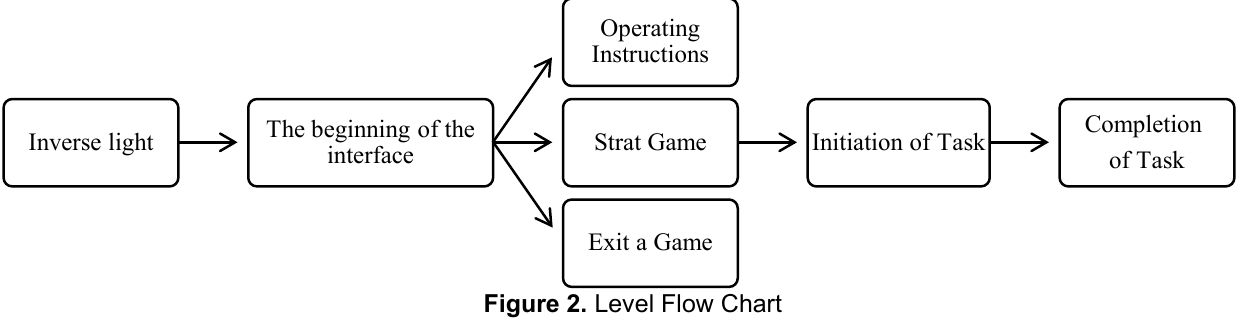
Figure 2. Level Flow